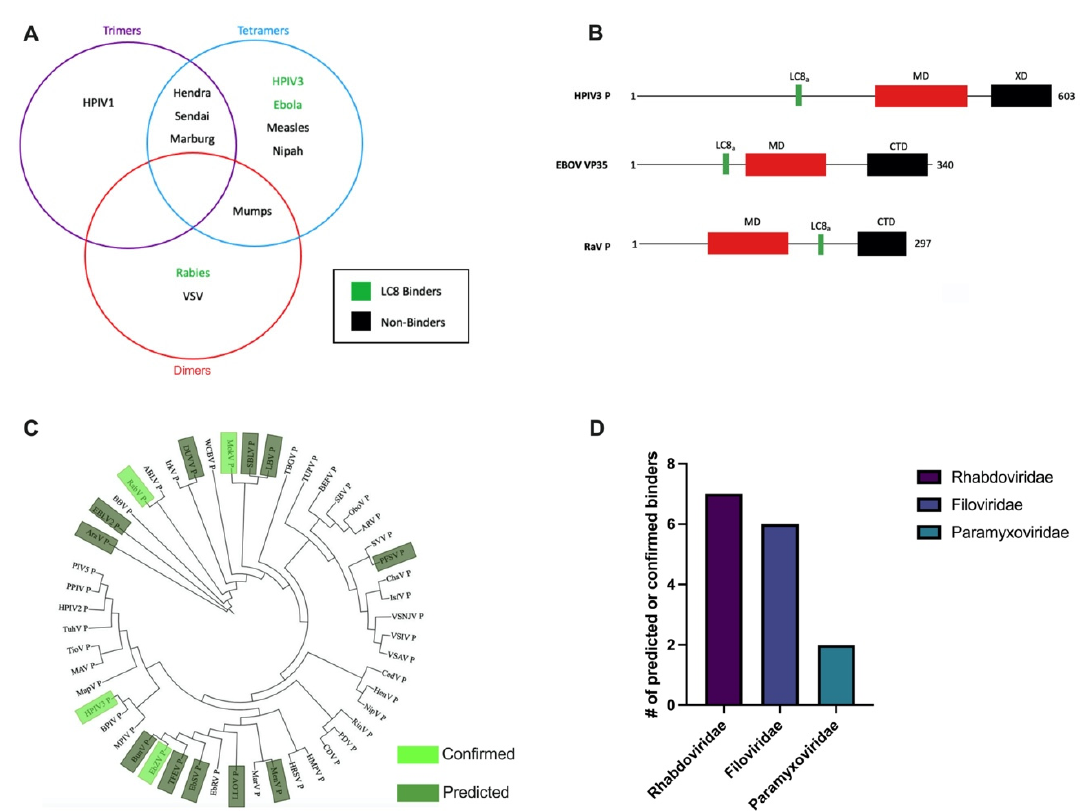
Figure 6. Oligomerization states and LC8 binding predictions among related viruses. ( A ) Venn diagram of phosphoprotein oligomerization states reported in the literature and those shown by our experiments [5,6,12,14–17,45,61–63]. Green, known LC8 binders; black, non-binders. ( B ) Domain architecture of HPIV3 P, EBOV VP35, and RaV P. Black lines, intrinsically disordered regions; red rectangles, multimerization domains; black rectangles, C-terminal domains; green rectangles, LC8 anchors. ( C ) Independent sequence alignment of phosphoprotein sequences of Filoviridae, Paramyxoviridae, and Rhabdoviridae and analysis with LC8Pred to determine binders; virus abbreviations found in Appendix A, Table A1. ( D ) Number of predicted or confirmed LC8 binding phosphoproteins in the corresponding families as shown in ( C ).